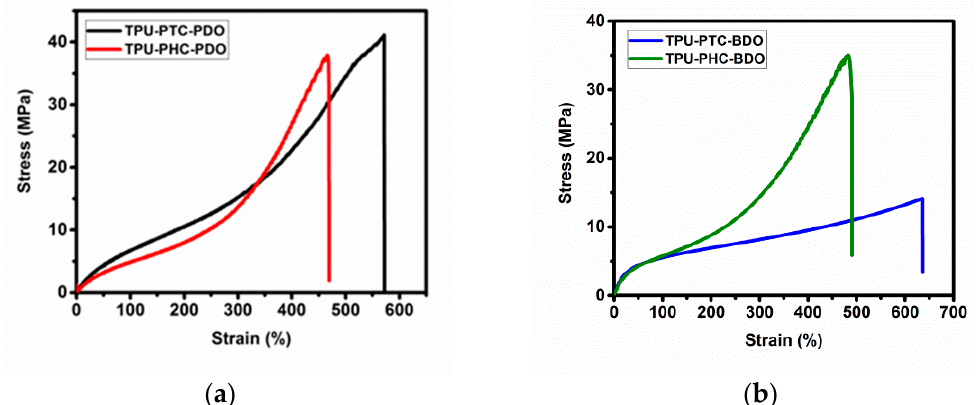
Figure 9. Stress–strain curve of TPU when the chain extender is ( a ) PDO or ( b ) BDO.